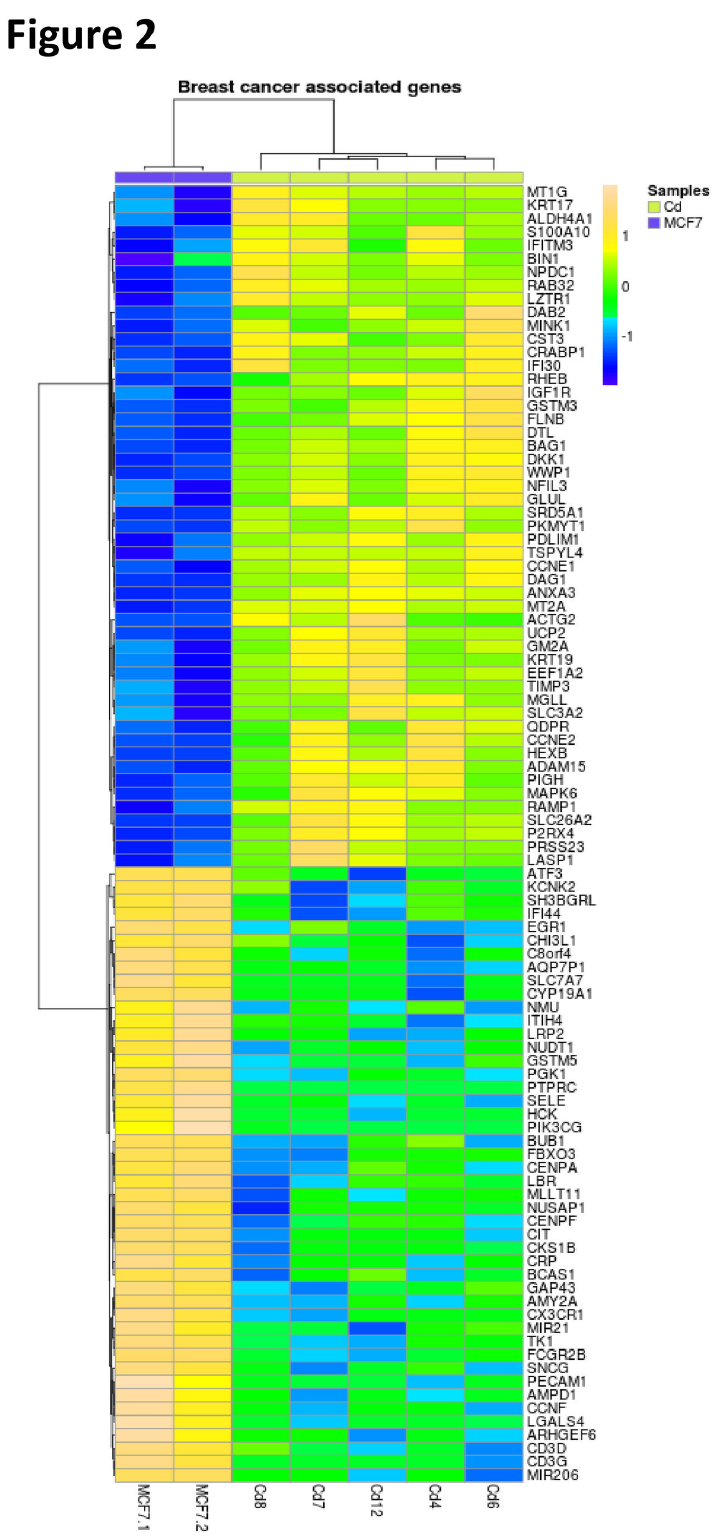
Figure 2. Heat map showing expression of 97 breast cancer associated genes that are differentially expressed between control and cadmium-adapted cells. Each row represents a gene and each column represents a sample. doi: 10.1371/journal.pone.0084646.g002 PLOS ONE |